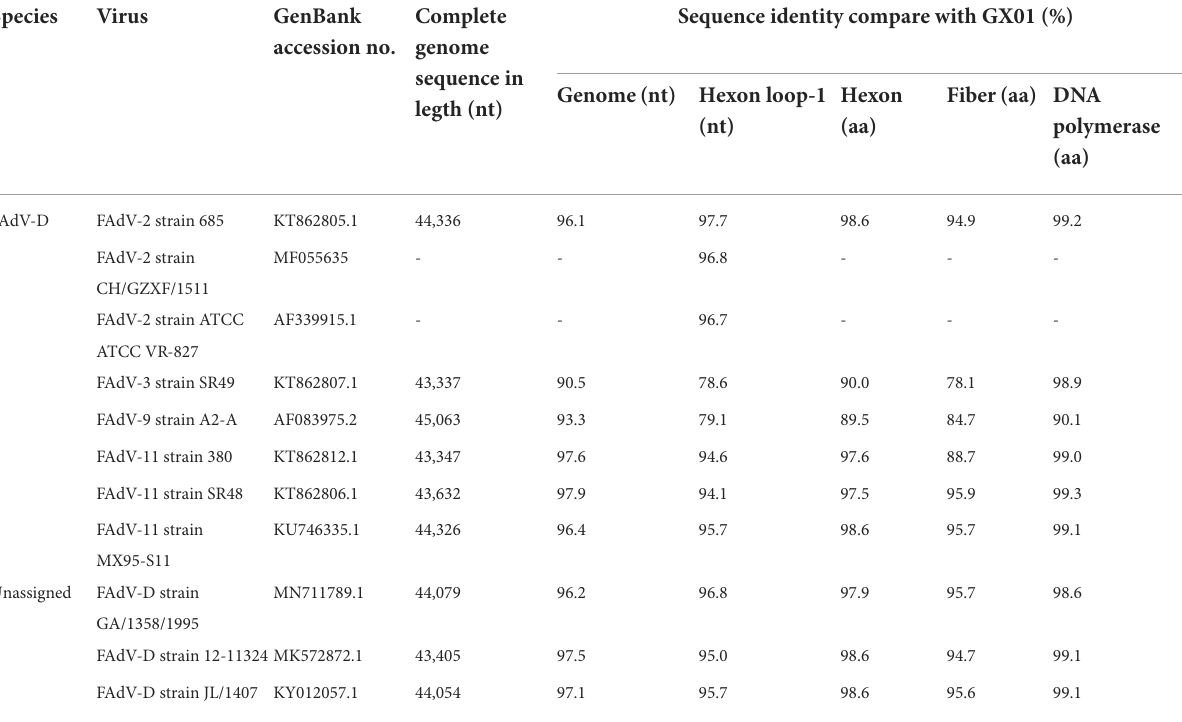
TABLE 1 Comparison of complete genome sequences, hexon loop-1 gene and amino acid sequences of the three ORFs of GX01 with other FAdV-D strains. Species Virus GenBank